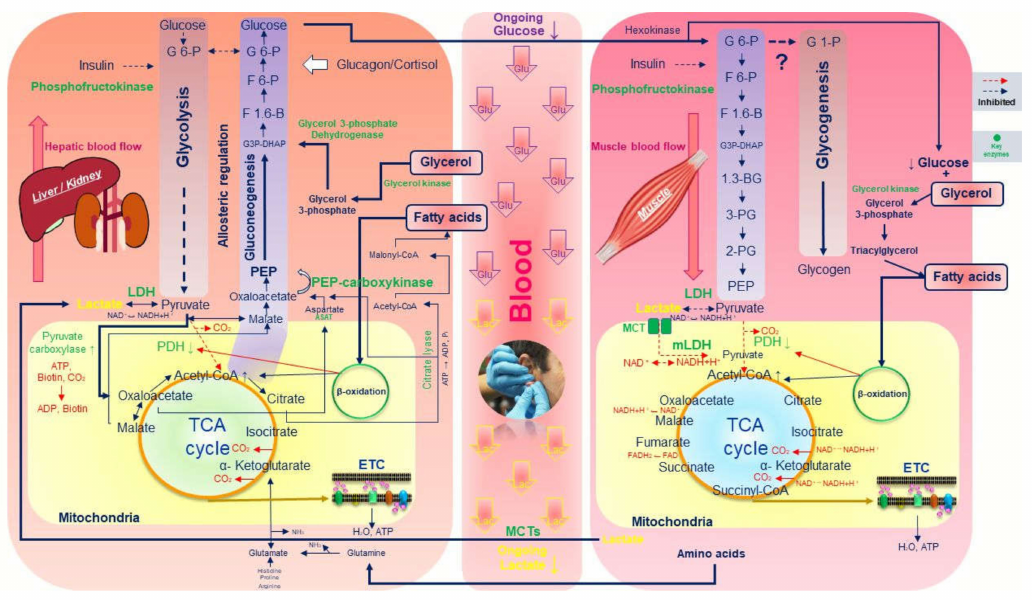
Figure 2. Summarized illustration of all described factors for decreased blood glucose and lactate values during the initial stages of lactate threshold test. ADP—adenosine